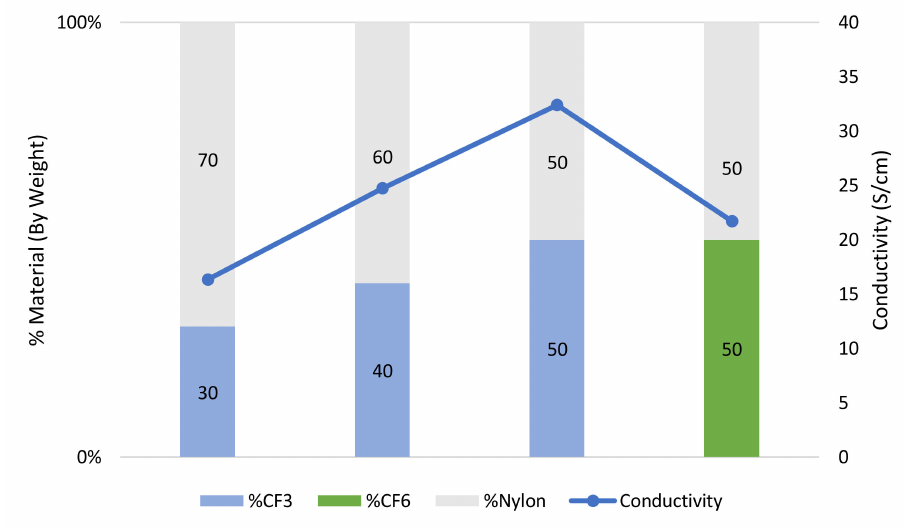
Figure 11. Electrical conductivity of the CF3 and CF6 composite